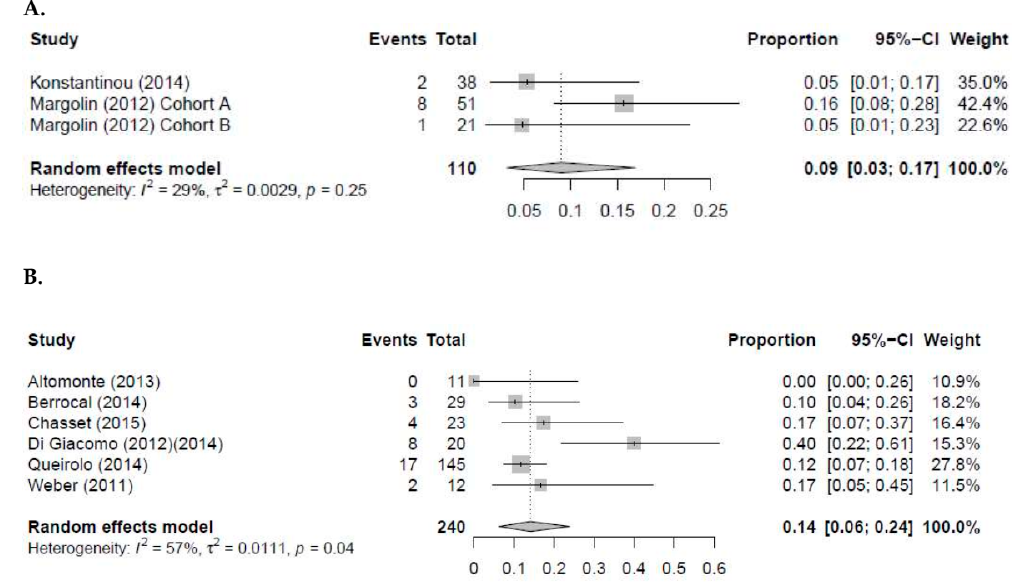
Figure 2. Pooled analysis for intracranial ORR ( A ) and overall ORR ( B ) of ipilimumab in patients with melanoma brain metastases.